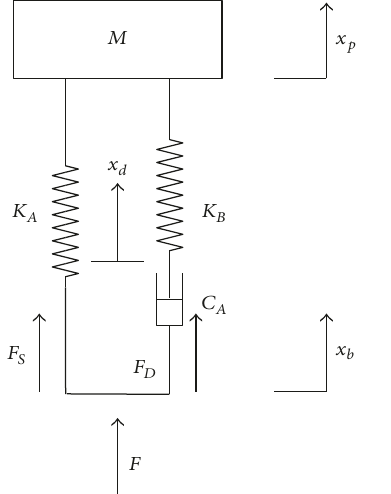
Figure 1: Three-parameter system (Zener model). Figure 2: Mechanical impedance